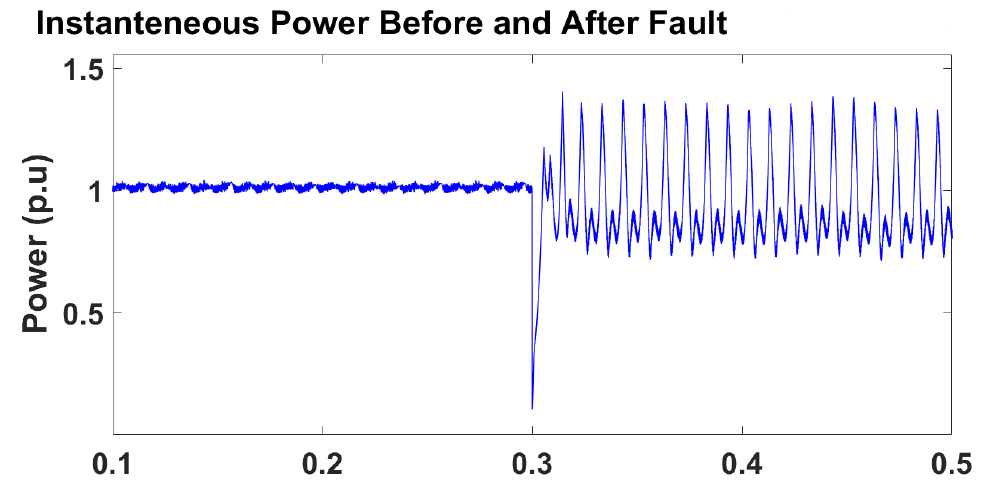
Figure 8. Instantaneous power flowing to grid before and after fault with conventional